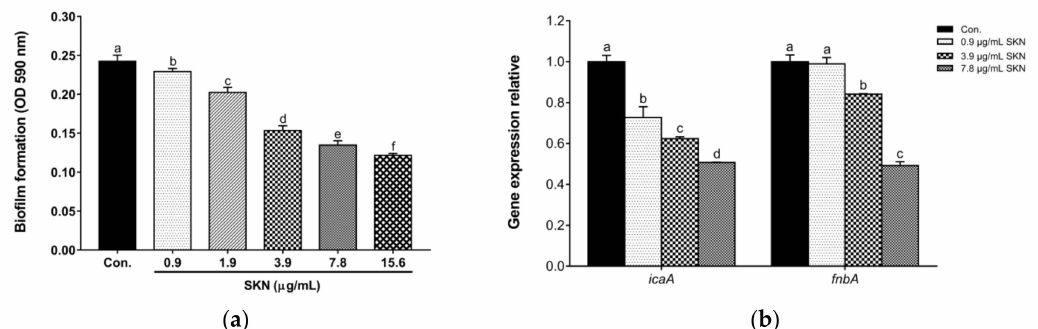
Figure 5. ( a ) The effect of SKN on the biofilm formation ability of MRSA DPS-1. ( b ) The effect of SKN on the expression of genes encoding surface-associated adhesins ( icaA and fnbA ). The data are means ± SD of triplicate determinations. Different letters on the bars indicate significant statistical differences between treatments ( p < 0.05), while the same letters mean no significant differences ( p >